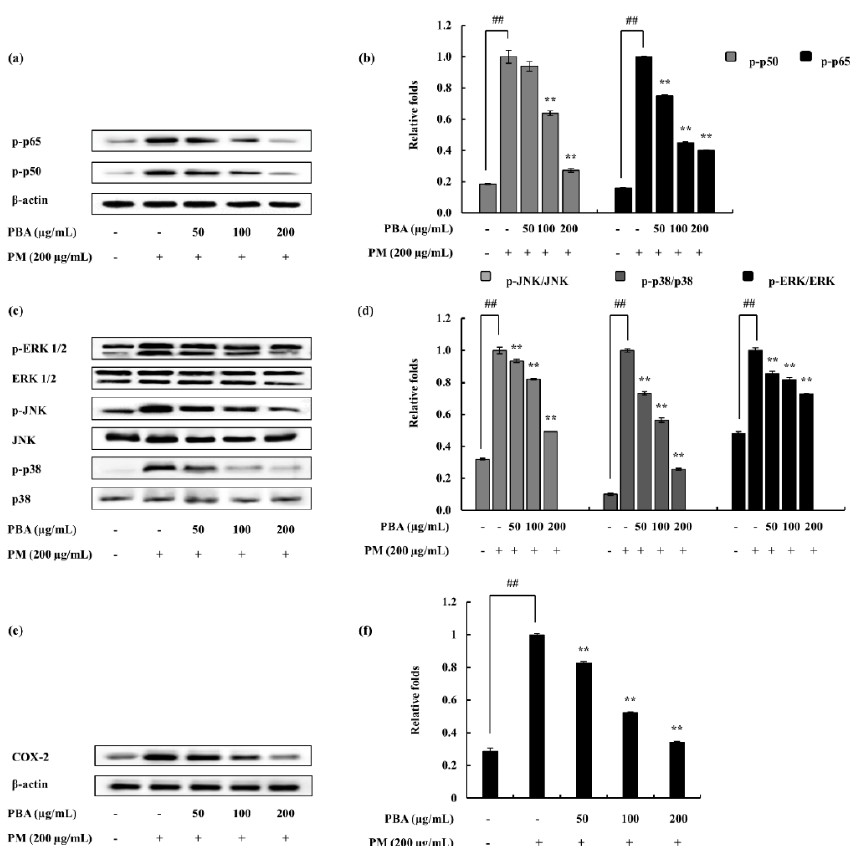
Figure 4. E ff ect of PBA on keratinocytes to inhibit NF- κ B-associated signals, MAPK pathway molecules, and COX-2. ( a ) p50 and p65 in the cytosol, ( c ) p38, JNK and ERK, ( e ) COX-2 data determined using Western blotting. Quantitative data were analyzed using ImageJ software ( b , d , f ). Results are expressed as the mean ± SD of three separate experiments. ** p < 0.01. (# denotes significance compared to control while * represents significance compared to the PM-treated